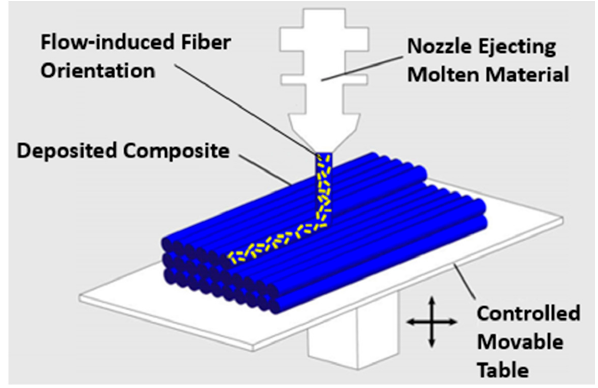
Figure 1. Flow-induced fiber orientation occurs during the process of large-scale additive